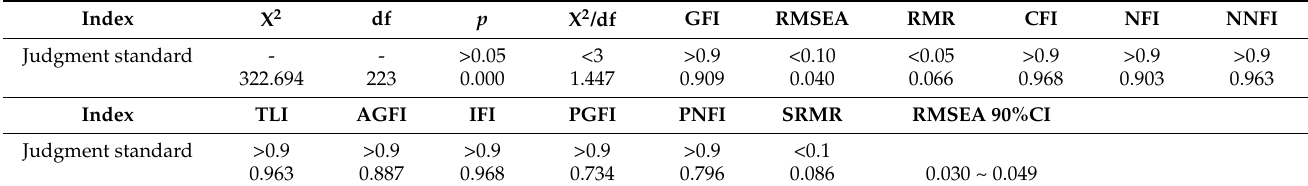
Table 7. Model fit